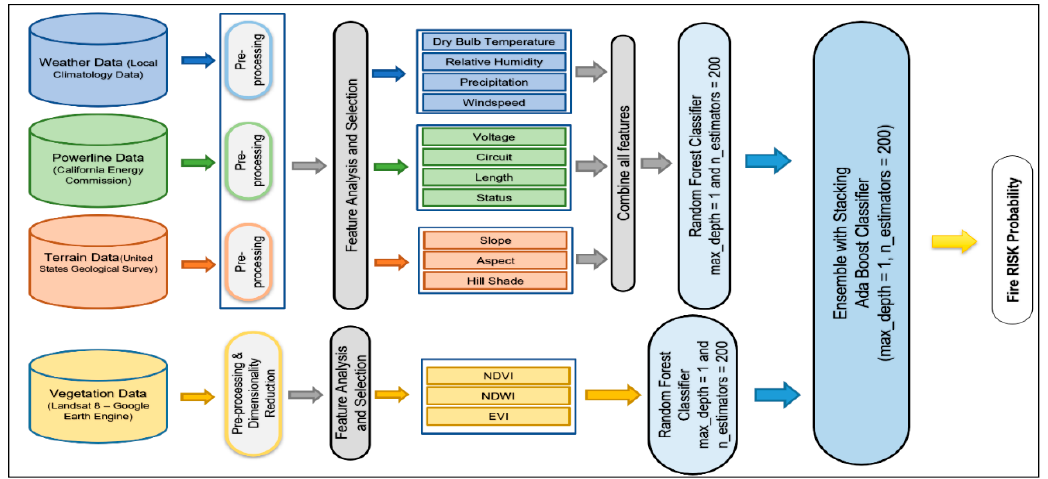
Figure 6. Architecture of the Ensemble (Adaboost) Random Forest models.